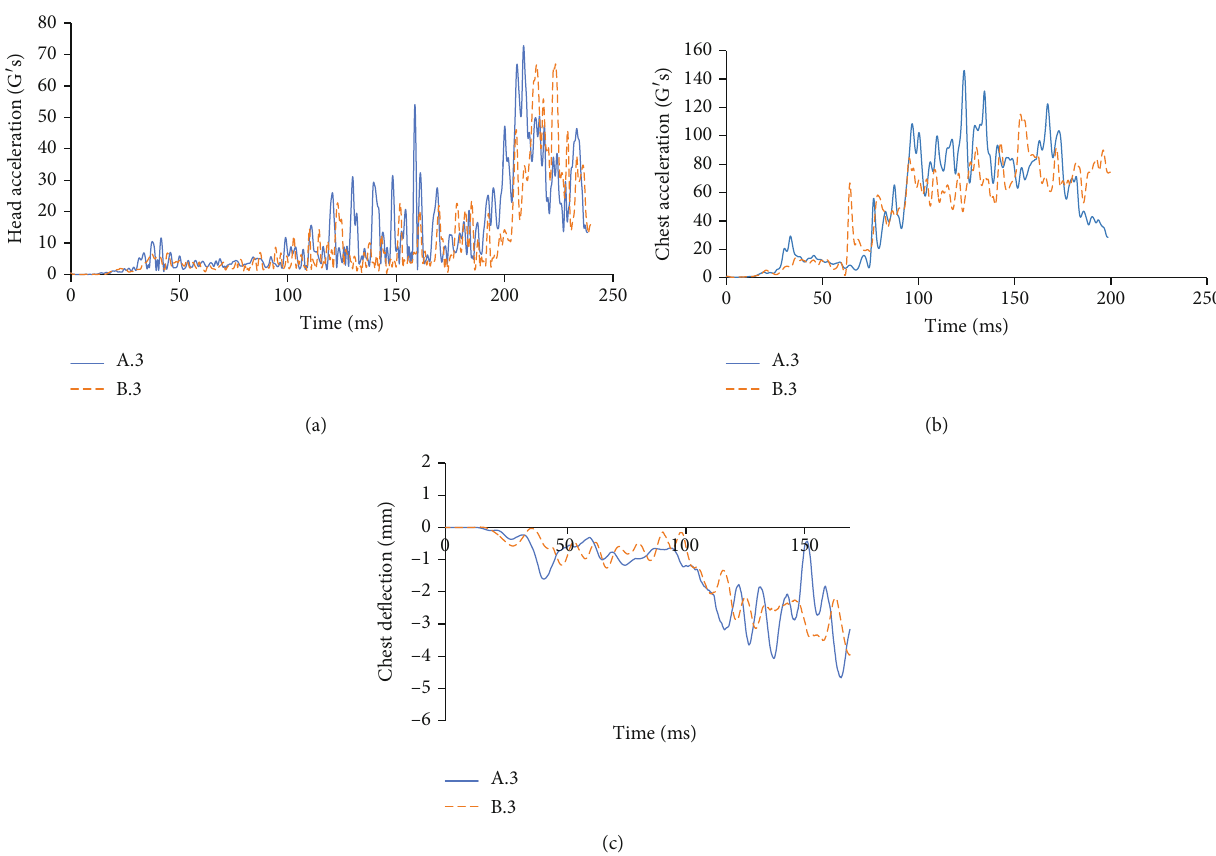
Figure 13: (a) Head acceleration in the center of gravity and HIC at a speed of 40 km/h. (b) Chest acceleration in G ’ s at a speed of 40 km/h. (c) Chest de fl ection in mm during the accident at a speed of 40 km/h.